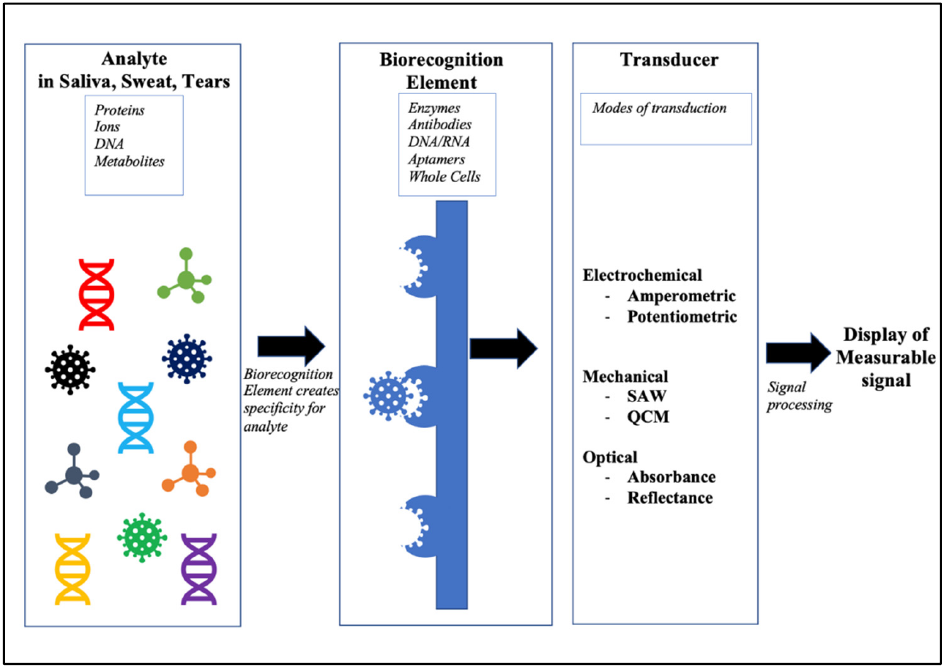
Figure 1. Schematic illustration of the basic parts of a biosensor and the working mechanisms. The analyte is usually the biomolecule that is recognized by the highly specific biorecognition element, and this reaction takes place on different transduction platforms, generating signals that are detected by transducers and converted into displayable data.